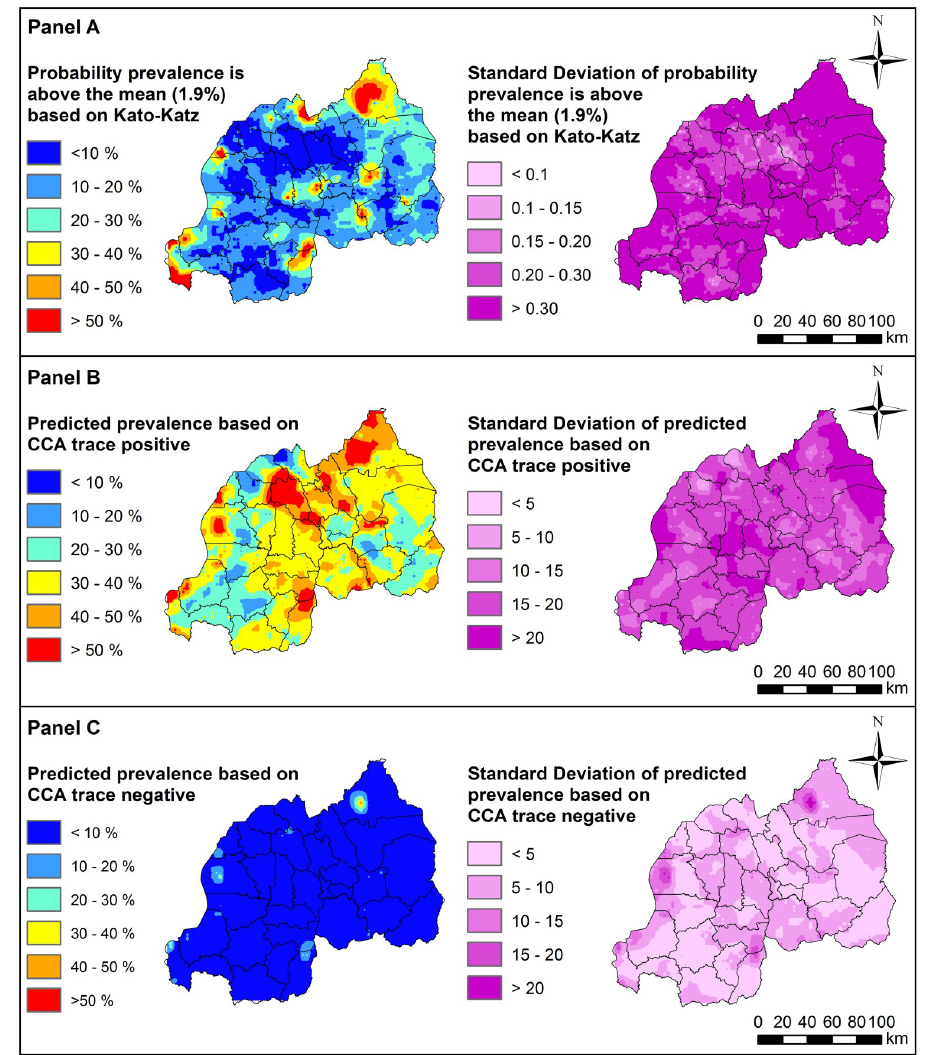
Fig 2. Predicted prevalence of Schistosoma mansoni infection in Rwandan boys aged 5–9 years, estimated using three different diagnostic methods: Kato-Katz (Panel A), CCA with trace as positive (Panel B), and CCA with trace as negative (Panel C). Predictions were generated using separate geostatistical models to account for possible discrepancies in diagnostic performance and estimates of geographical endemicity. Refer to S3 Fig in Supporting Information for names of geographical districts. This figure was produced in ArcMap 10.4 (ESRI, Redlands, CA) using a shapefile representing Rwanda’s current administrative units (obtained from the geographic data warehouse DIVA GIS (www.diva-gis.org/Data)). CCA; Circulating Cathodic Antigen.